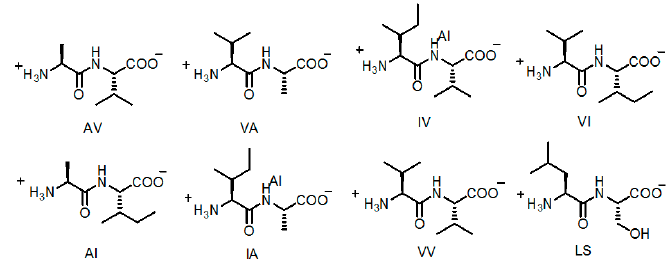
Figure 15. Structures of the building motifs of H14a – 14h . Table 2. Average channel diameter and porosity in H14a – 14h .